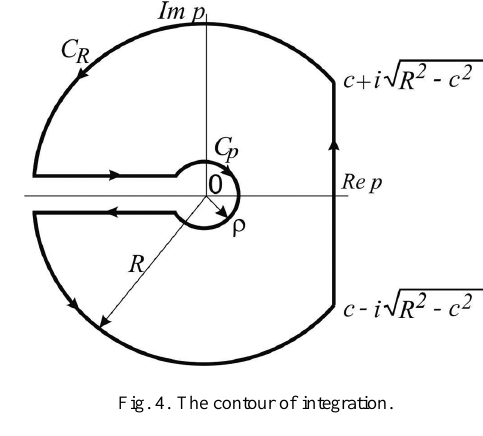
Fig. 4. The contour of